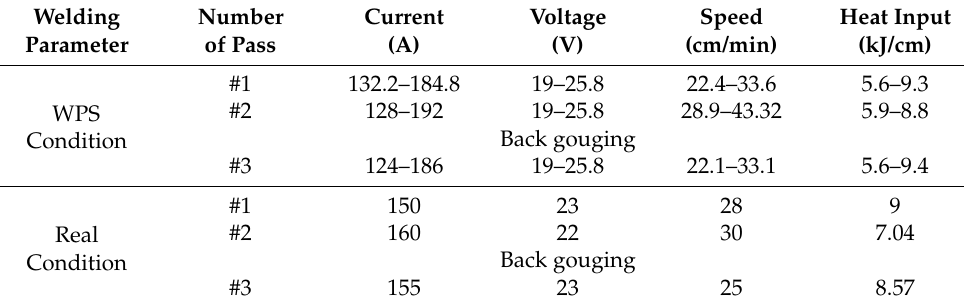
Table 4. Heat input parameter for butt welding.